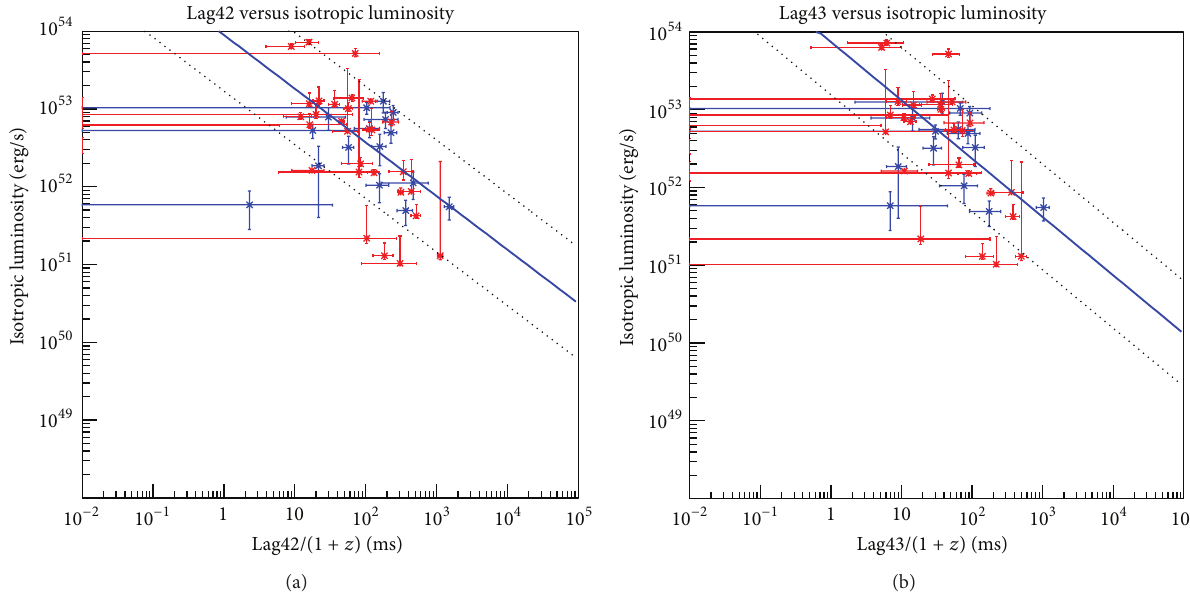
Figure 3: The lag versus isotropic peak luminosity. The blue points are our results. The red points are the results which are reported in Ukwatta et al. 2010. The blue lines are best fit values of power-law fitting. The black dotted lines show the region corresponding to variance 𝜎 𝐿 Between 100–200 keV and 25–50 keV and (b) between 100–200 keV and 50–100keV.